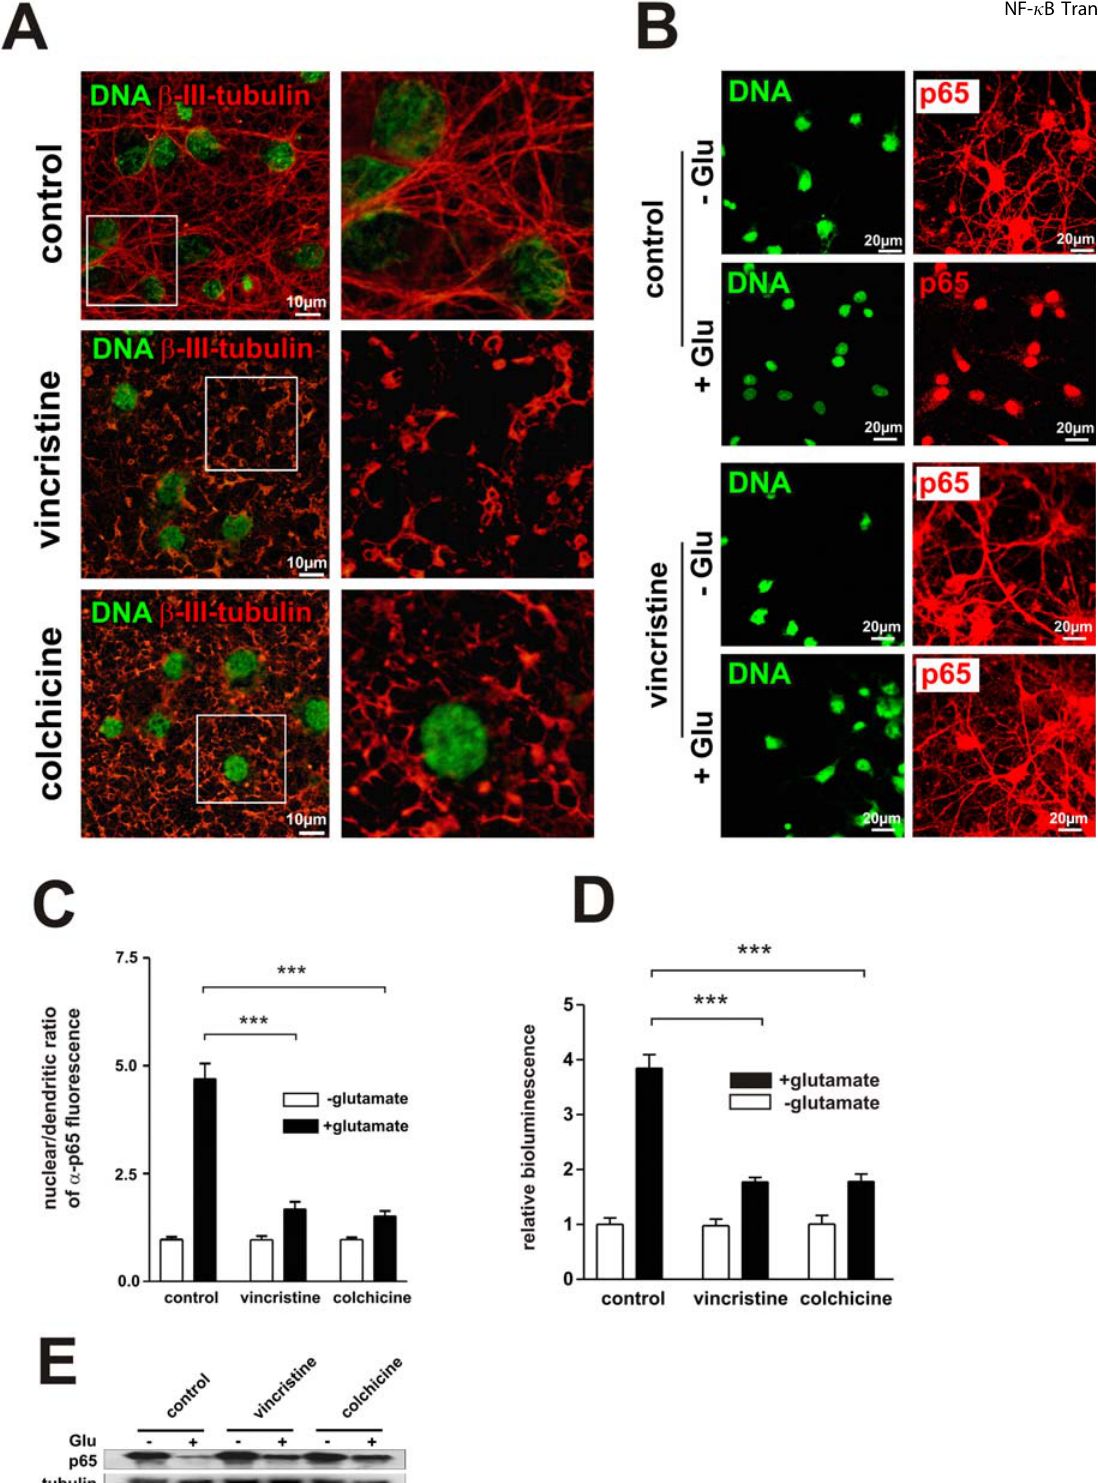
Figure 4.Microtubule-perturbing drugs inhibit neuronaltransport of NF- k B. (A) Effectofmicrotubule-perturbing drugs onthe organizationofneuronal microtubule network. Microtubule network was visualized by a 2 tubulin immunostaining. Treatment of hippocampal neurons with 200 nM colchicine or 100 nM vincristine resulted in efficient depolymerisation, as shown by the diffuse tubulin staining and the loss of the well-organized microtubule patterns seen in untreated cells.(B) Hippocampal neurons treated with 300 m M glutamate for 5 min, either alone or after pre-treatment with 200 nM colchicine or 100 nM vincristine for 30 min were fixed (90 min after glutamate exposure) and visualised by SYTOX nuclear staining (green) and anti-NF- k B p65 immunofluorescence (red) to monitor neuronal transport of NF- k B (C) Quantification of nuclear/dendritic ratio of a -p65 fluorescence in neurons with functional or disrupted microtubules. Note that microtubule-perturbing drugs impaired dendritic to nuclear redistribution of NF- k B p65 after glutamate stimulation. (D) Reporter gene assay showed reduced NF- k B-dependent transcription activity in neurons with not functional microtubules. (E) In order to confirm the data obtained by microscopy, the subcellular localization of p65 was examined by cell fractionation and Western blotting. 250 m g of soluble protein from cytoplasmic extracts were immunoblotted for p65 protein level. In agreement, with the above experiments,pre-treatment with vincristine or colchicines before exposure to glutamate resulted in reduced relocation of p65 from cytoplasm to the nucleus. doi:10.1371/journal.pone.0000589.g004 PLoS ONE |